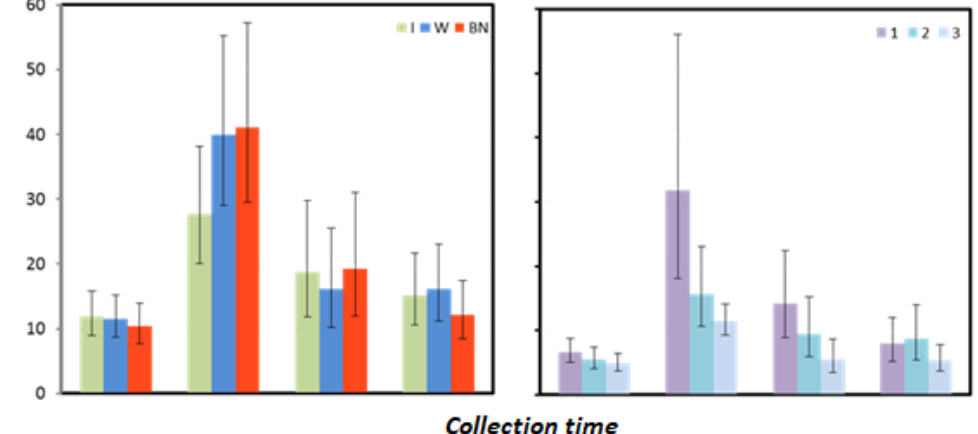
Figure 5. Myoglobin mean values estimated via the least squares method together with upper and lower confidence intervals for four measurements using three rehydration strategies [ng.mL −1 ].